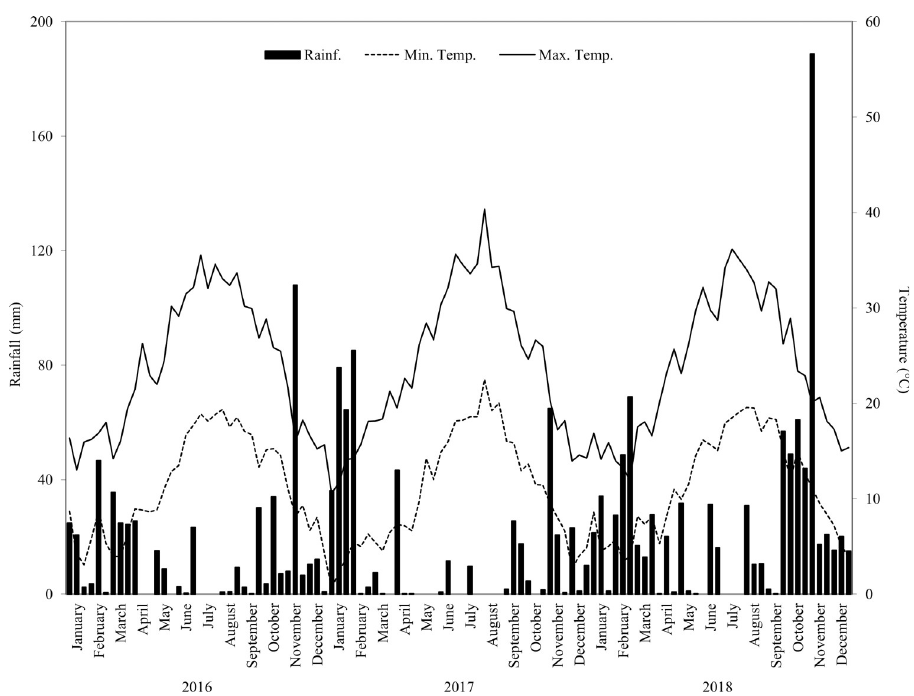
Fig 1. Rainfall and air temperature trends during the test period in the experimental area. For each month, three 10-day periods are shown.